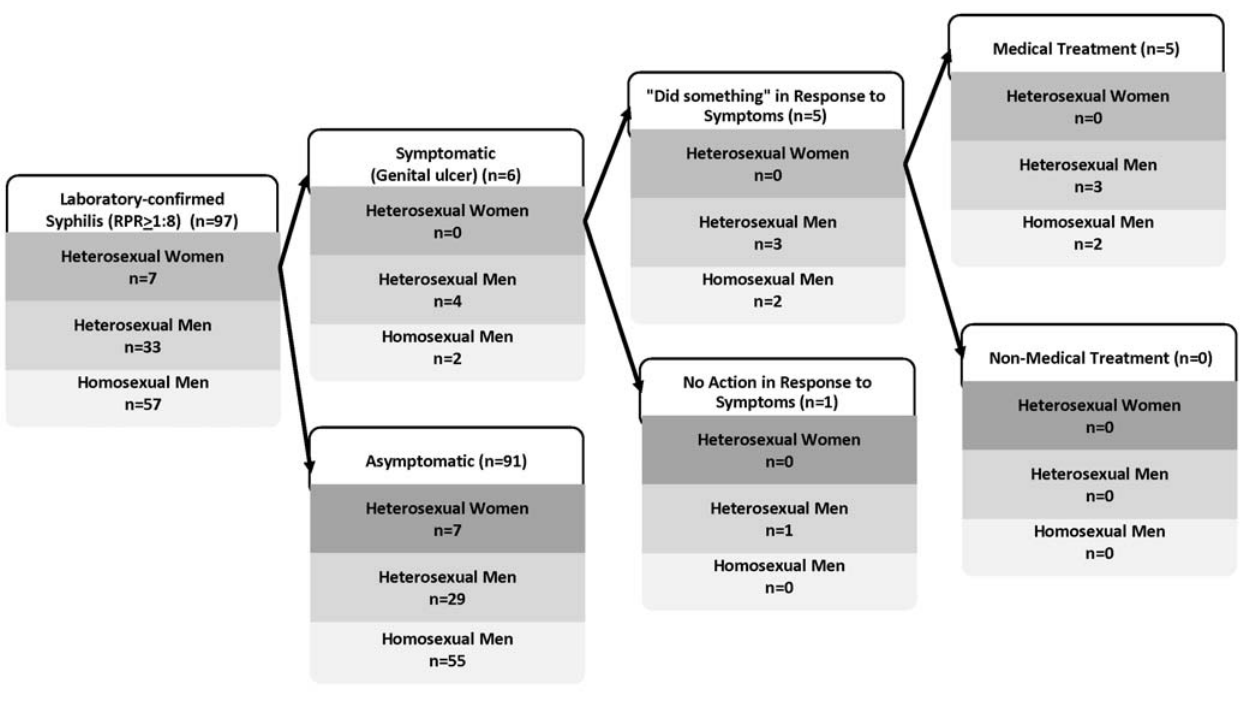
Figure 2. Pre-enrollment Treatment Outcomes Among Men and Women with Recent Syphilis (RPR $ 1:8); Lima, Trujillo and Chiclayo, Peru 2003–05.